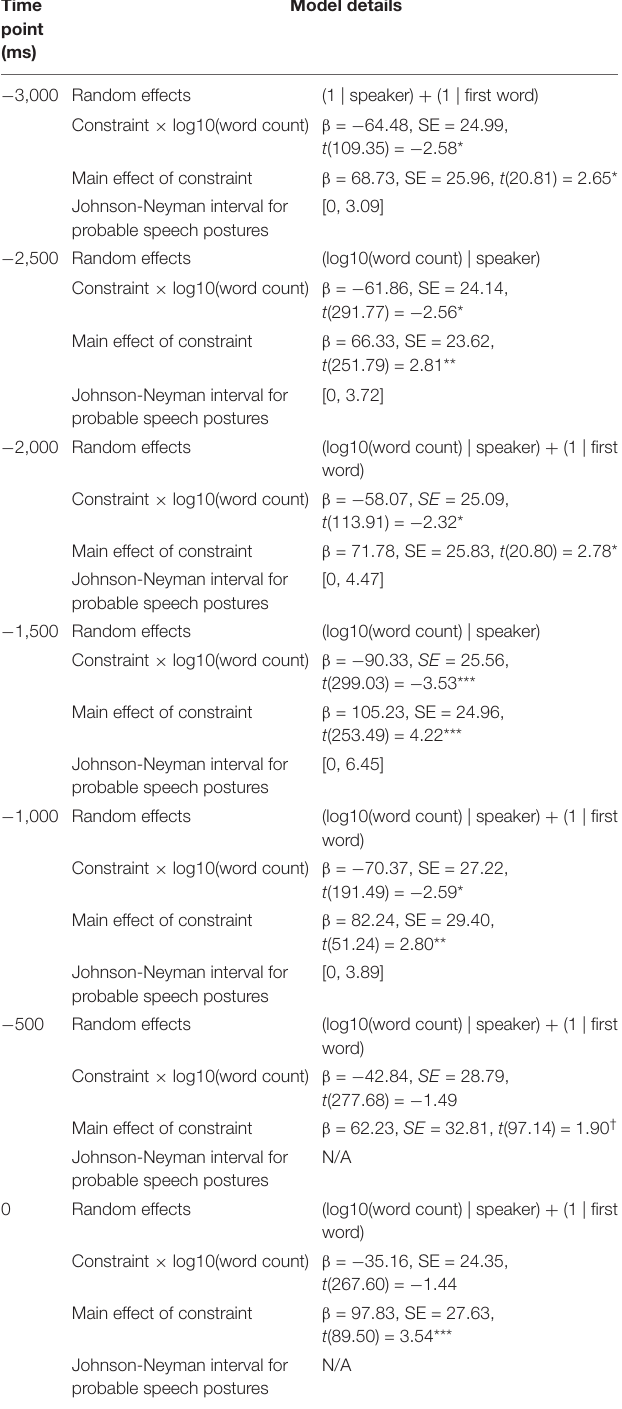
TABLE 2 | Reports of linear mixed models fit to lip